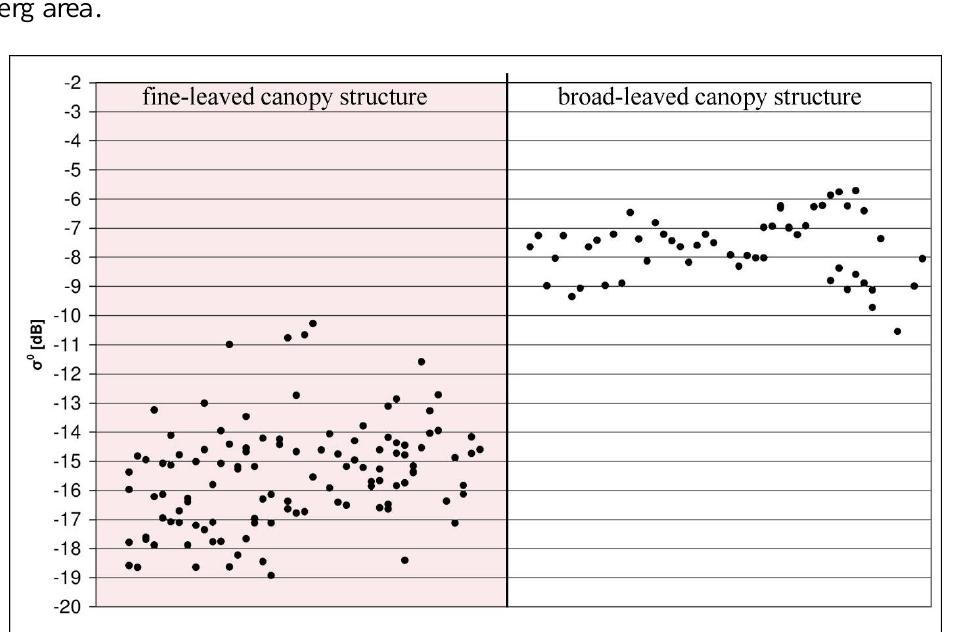
Figure 4. Mean backscatter values per field in June 2009 for VV polarization in the Fuhrberg area.